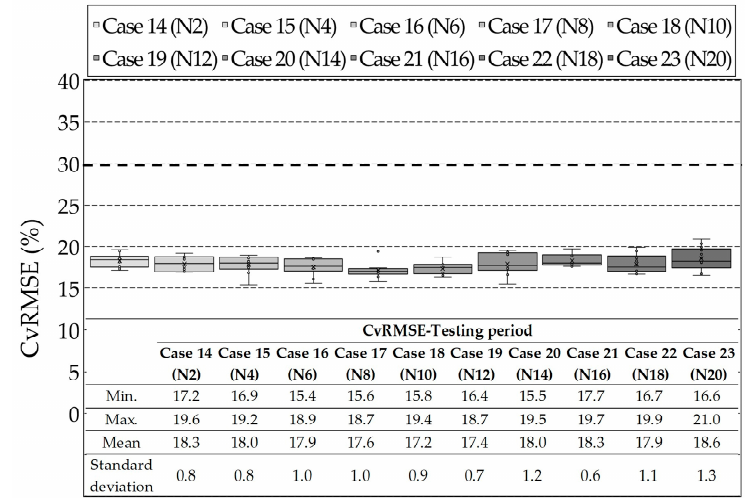
Figure 8. Accuracy according to the number of neurons for the testing period.